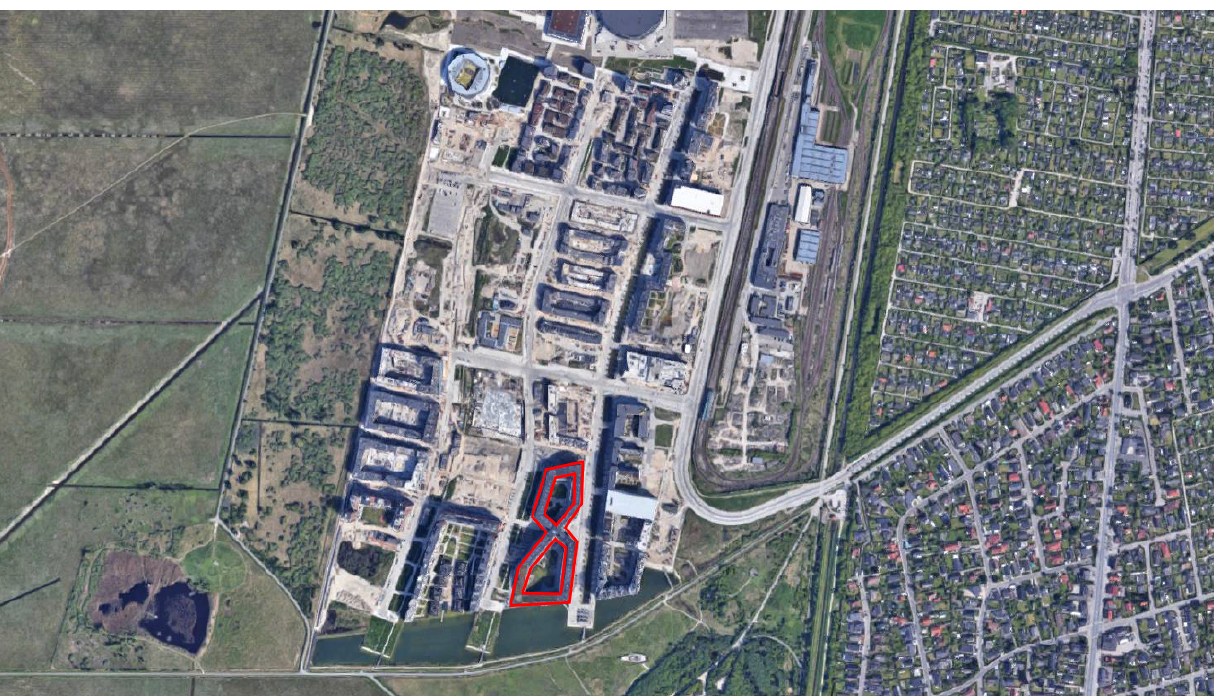
Figure 11. 8 House aerial view on the edge of the south section of Ørestad. Source: Authors